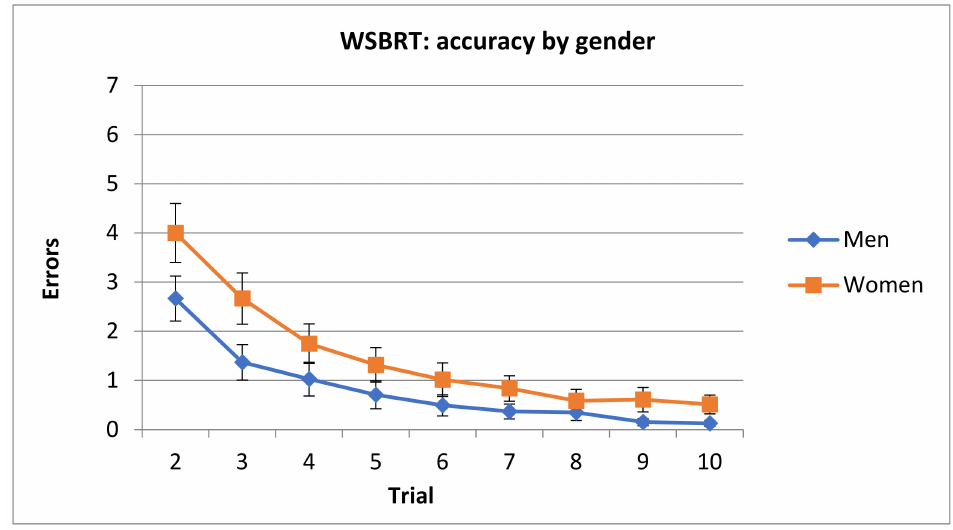
Figure 4. Mean number of errors committed in the WSBRT divided by trials. Note that trial 1 was removed from analysis since performance was at random. (Mean ±